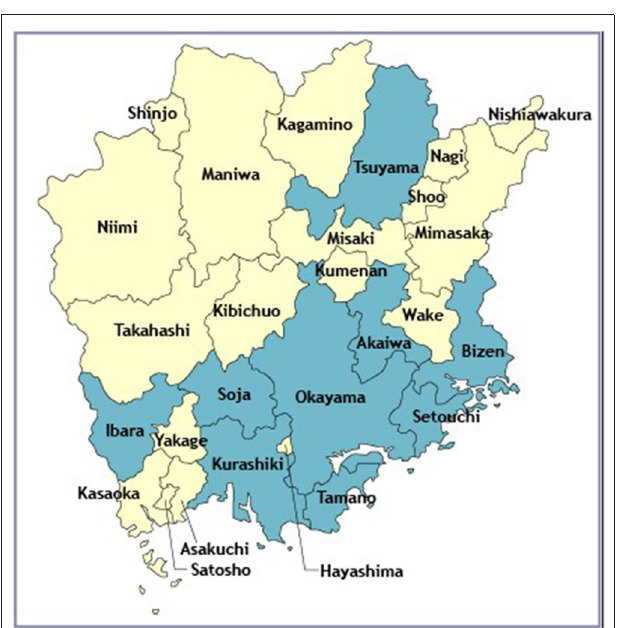
FIGURE 2 | Okayama city in Okayama